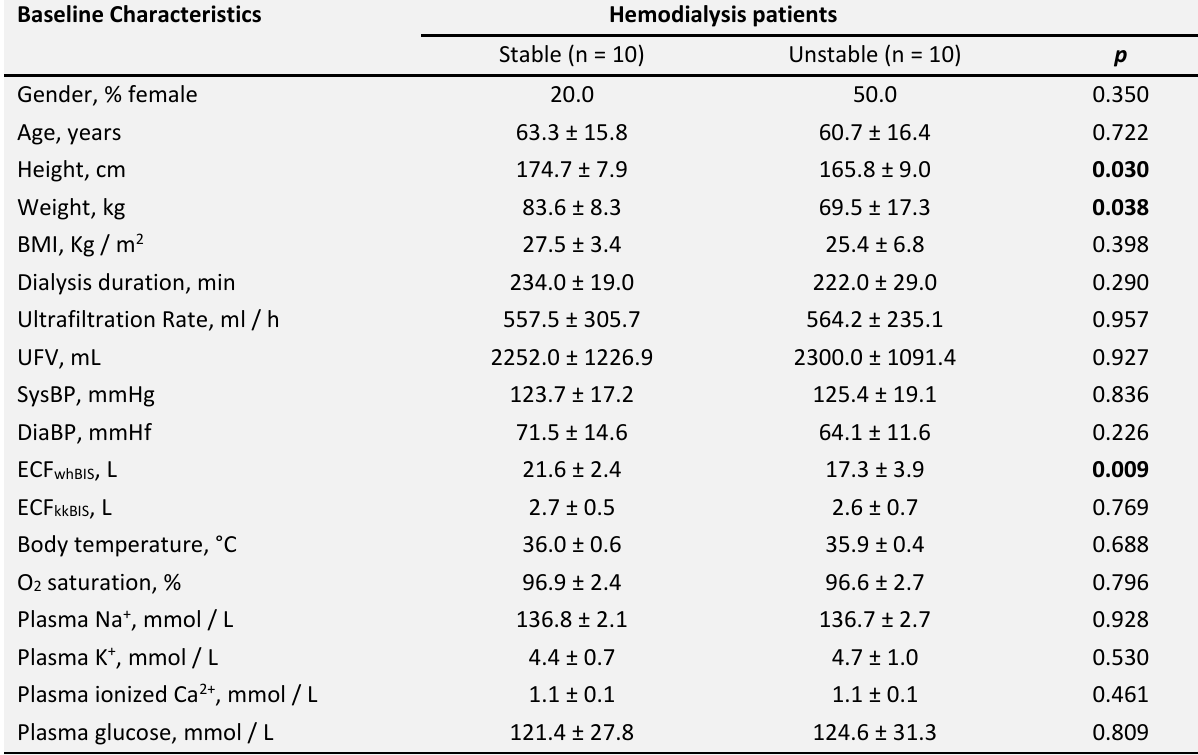
Table 1 Pre-dialysis physical and clinical characteristics. Data are means ± SD from 20 patients (40 measurements).